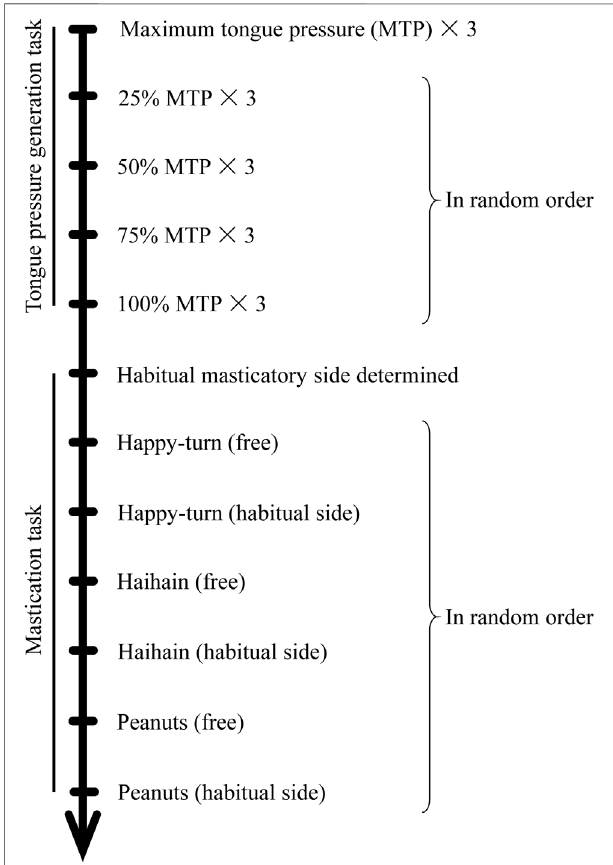
FIGURE 2 | Experimental